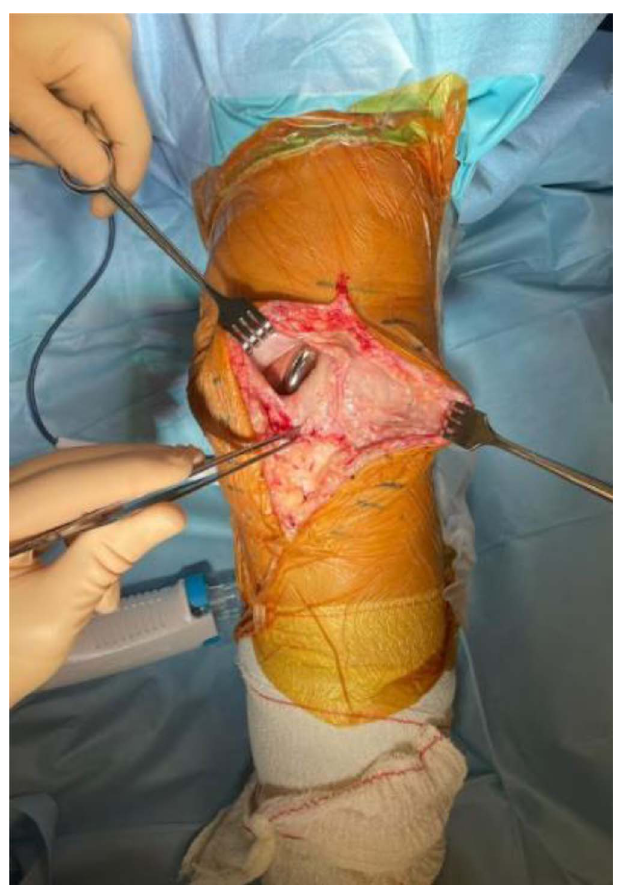
Figure 4. Medial retinaculum defect and quadriceps chronic degeneration.